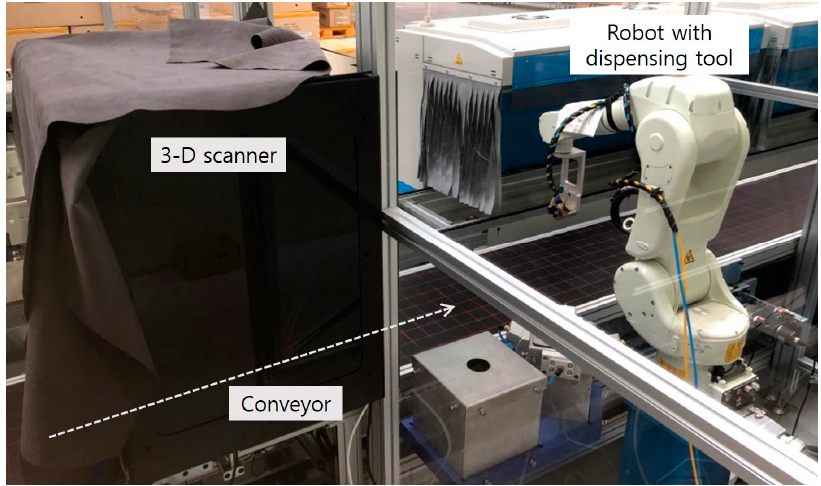
Figure 1. Dispensing robot and 3-D scanner in a shoe manufacturing process.